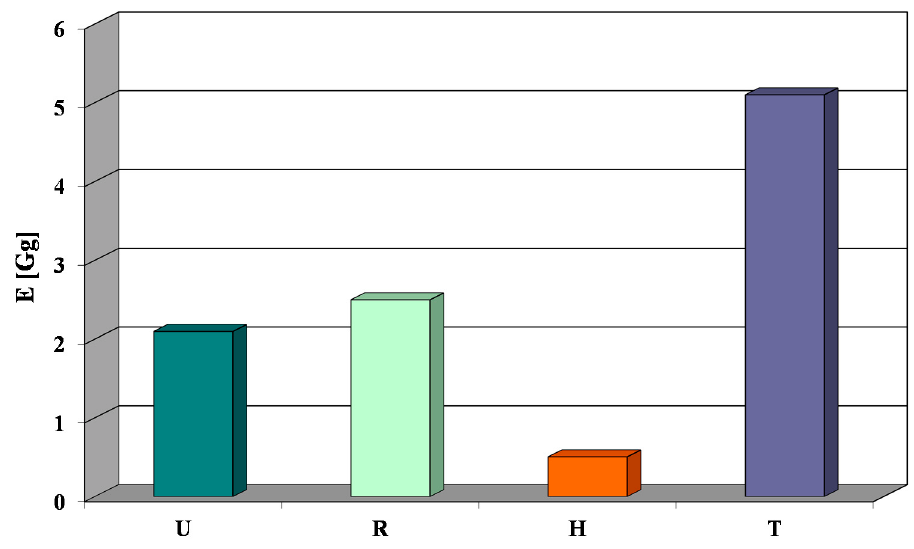
Figure 12. National annual emissions (E) of non-exhaust particulate matter PM2.5 (PM2.5-N-Exh) under different traffic conditions: urban (U), rural (R), highway (H) and total (T).